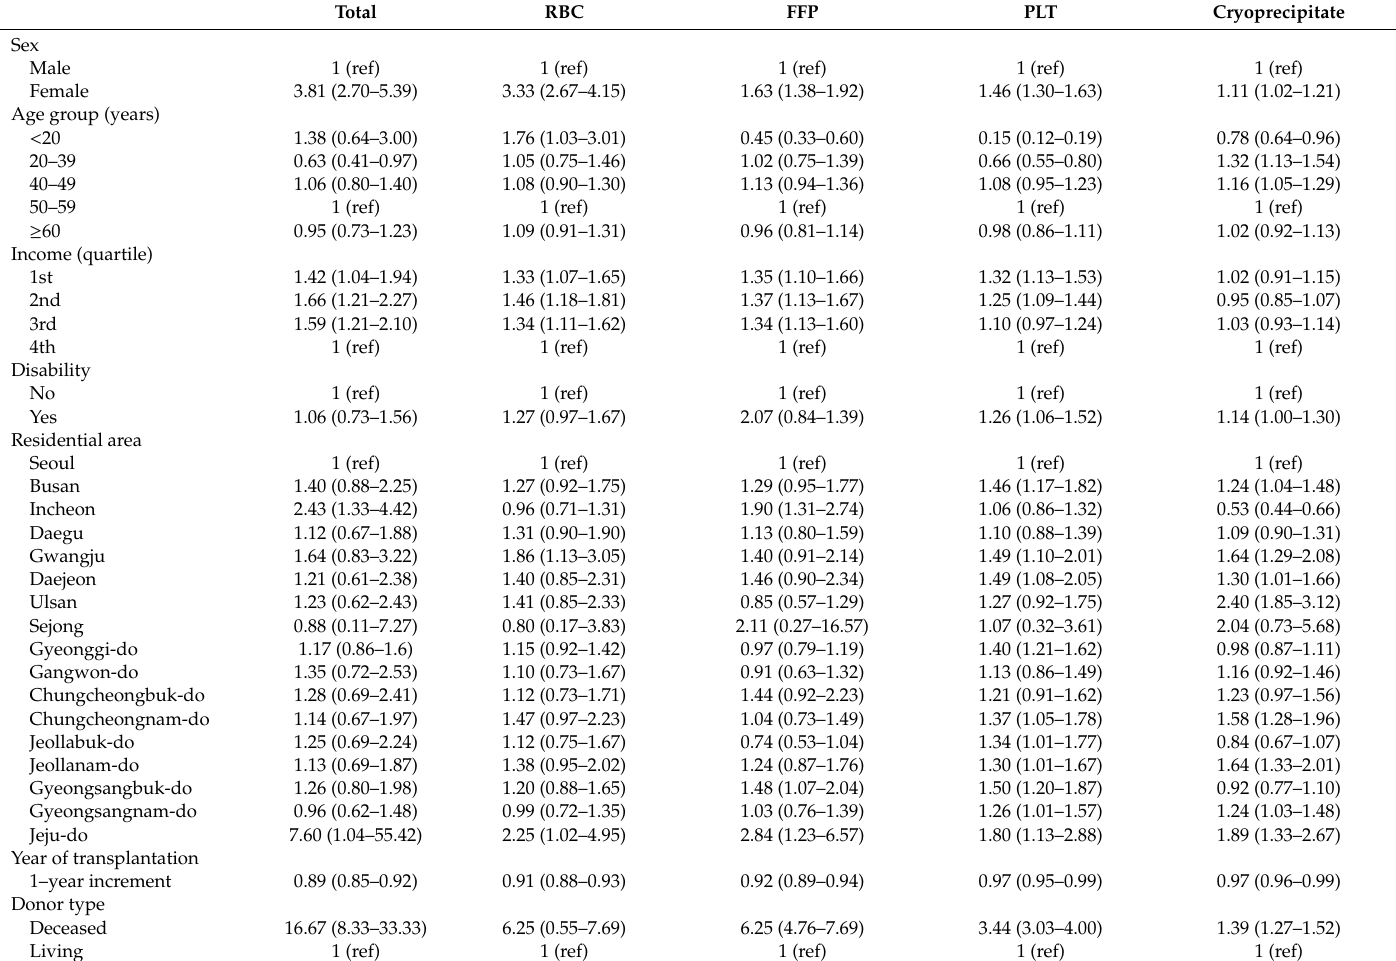
Table 2. Factors associated with transfusion among liver